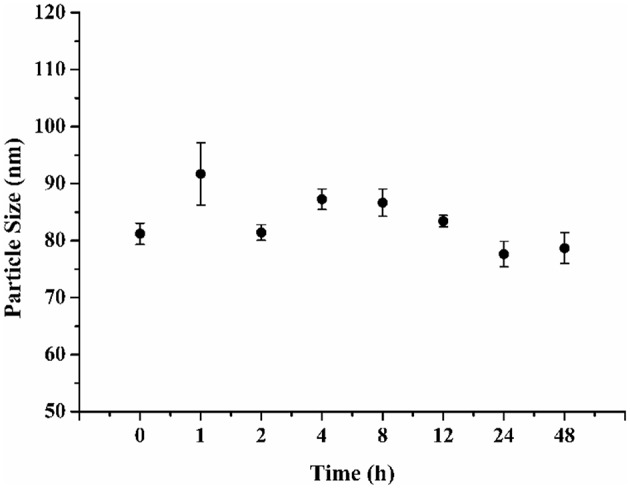
Changes in particle size of FA-CA-DOX micelles in PBS (0.15 M, pH 7.4) at 4°C.